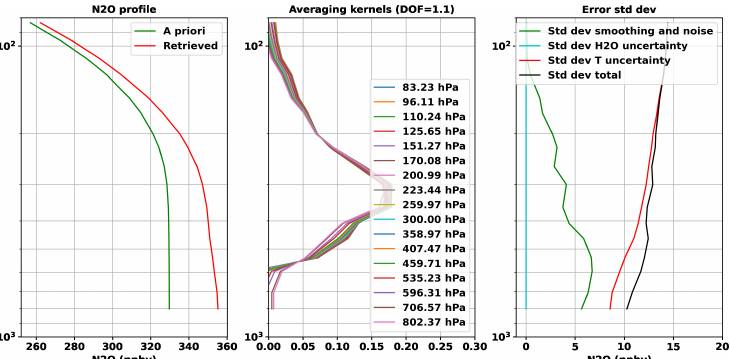
Figure 12. Example of retrieval results, averaging kernels and error analysis for a high South latitude (80.2° S, 0.2° E), 15 December